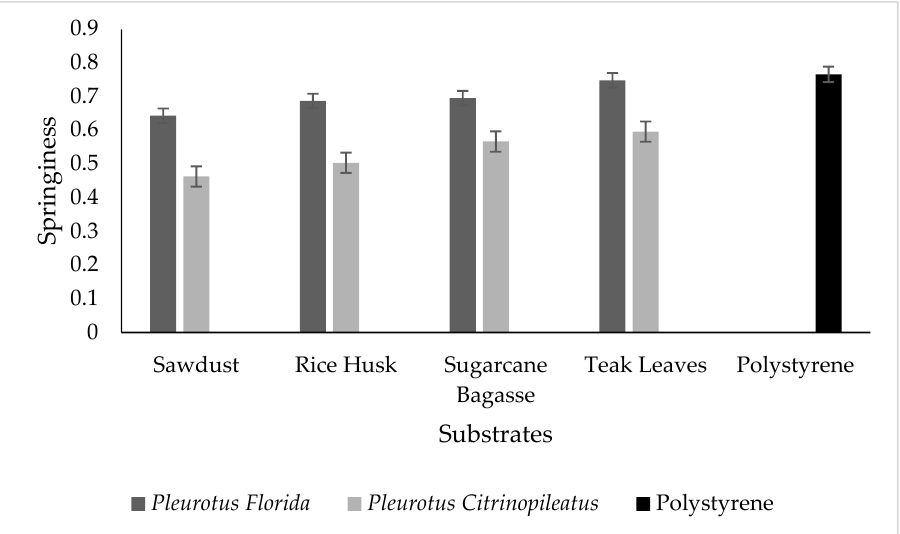
Figure 4. Springiness for different mushroom species of fungal foam in various types of substrates and polystyrene as the control.